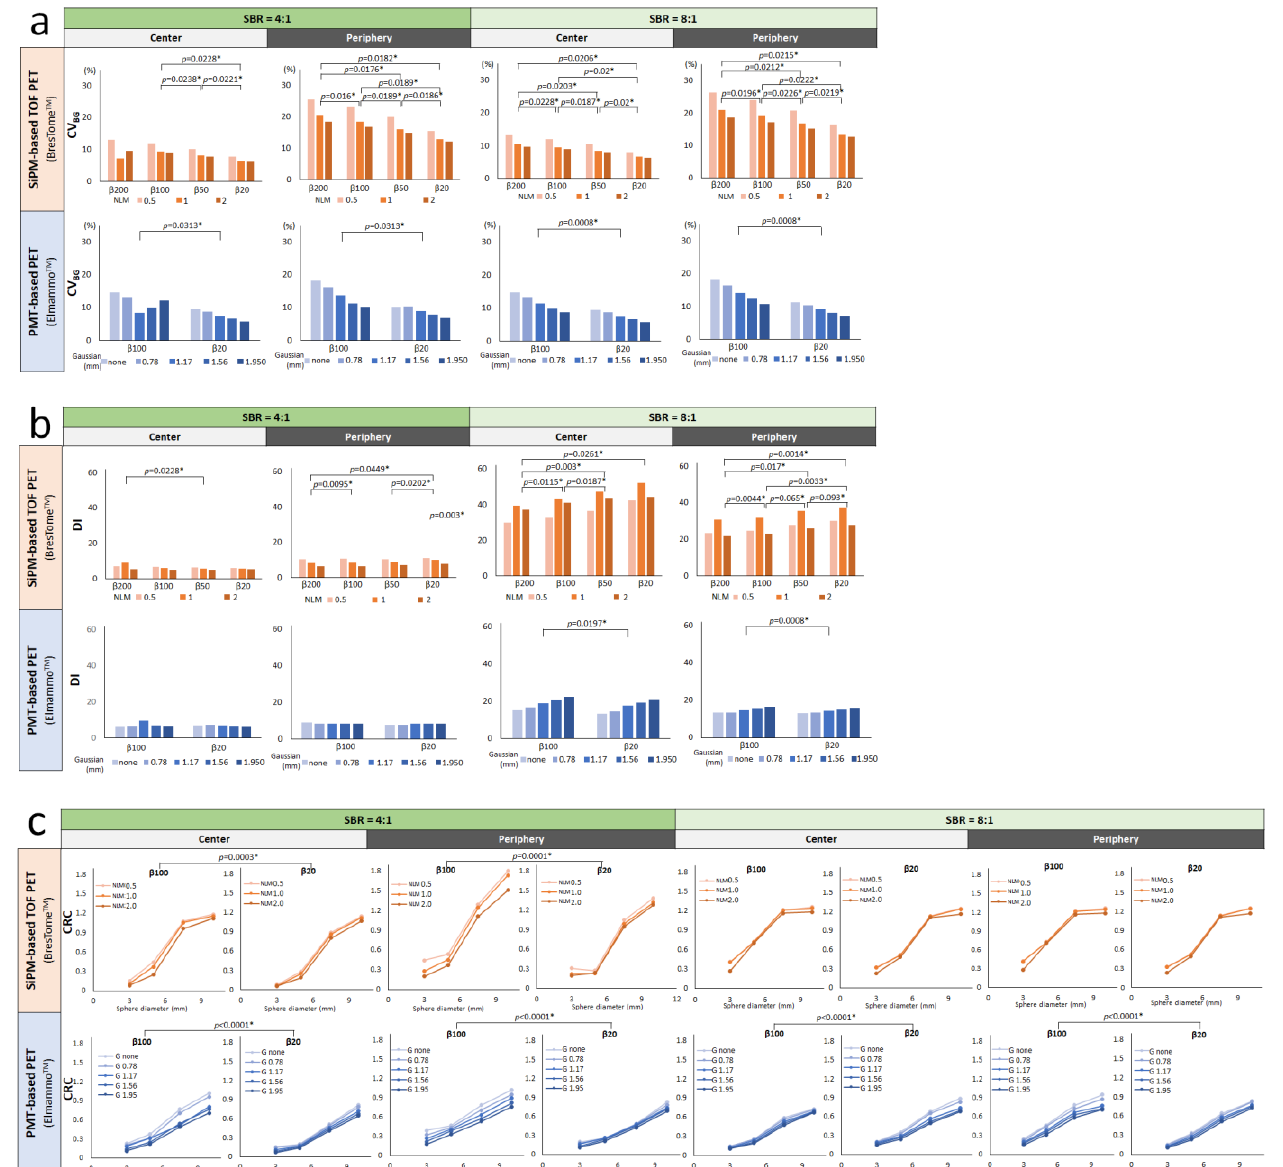
Figure 6. CV BG ( a ), detectability index ( b ), and CRC ( c ) of the breast phantom images with an SBR of 8:1 obtained with the two organ-specific PET scanners. * Statistically significant.